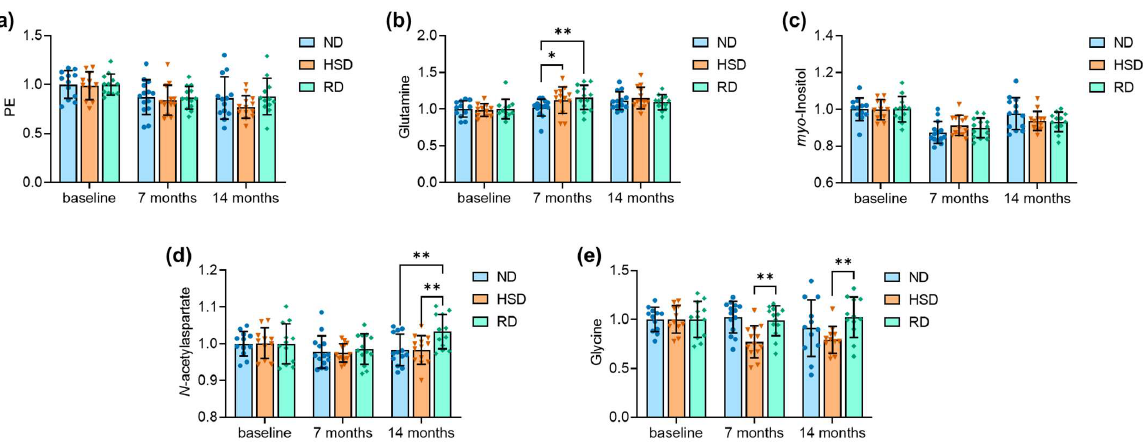
Figure 3. Cortical VIP metabolite concentrations for PE ( a ), glutamine ( b ), myo -inositol ( c ), N-acetylaspartate ( d ) and glycine ( e ) representing the main age- and/or diet-induced alterations to metabolite profiles. Data are normalized to the mean baseline concentration within each experimental group. Bars are means ± SDs. Symbols overlaid on bars represent independent measurements from each mouse for normal (ND), high-salt (HSD), and reversed (Rev) diet groups. * p < 0.05, ** p < 0.01, compared to ND or as indicated using Fisher LSD tests after significant effects of diet were determined by two-way ANOVA.